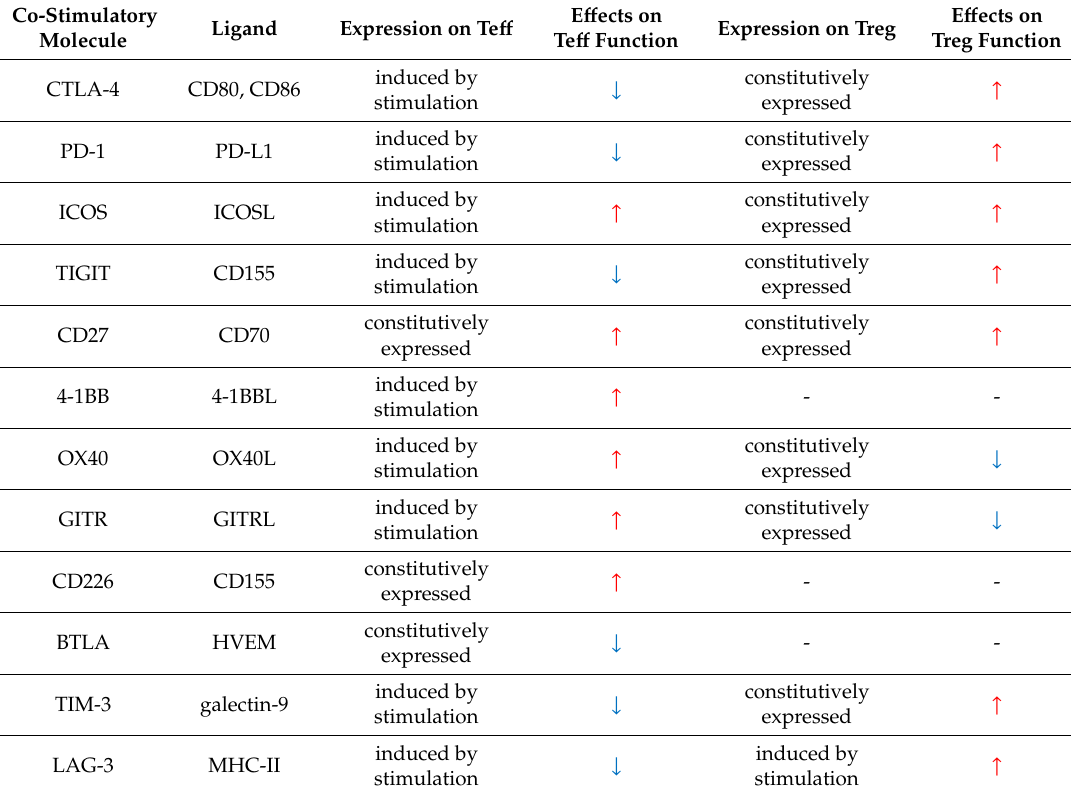
Red arrows indicate the signals reinforcing the immune responses to cancer, while blue arrows indicate the signals causing attenuation of such responses. Te ff : e ff ector T cell. Treg: regulatory T